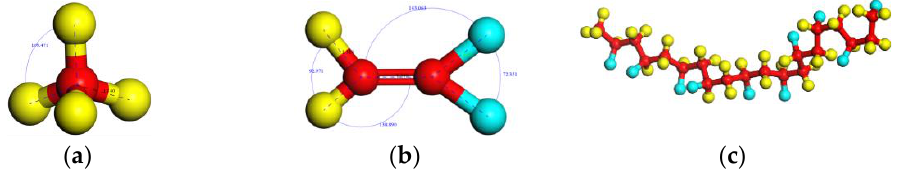
Figure 1. Gas molecules and polymer molecules: ( a ) CH 4 , ( b ) VDF monomer, ( c ) PVDF chain ( n = 10) . Colored balls represent C in red, H in yellow, F in blue.